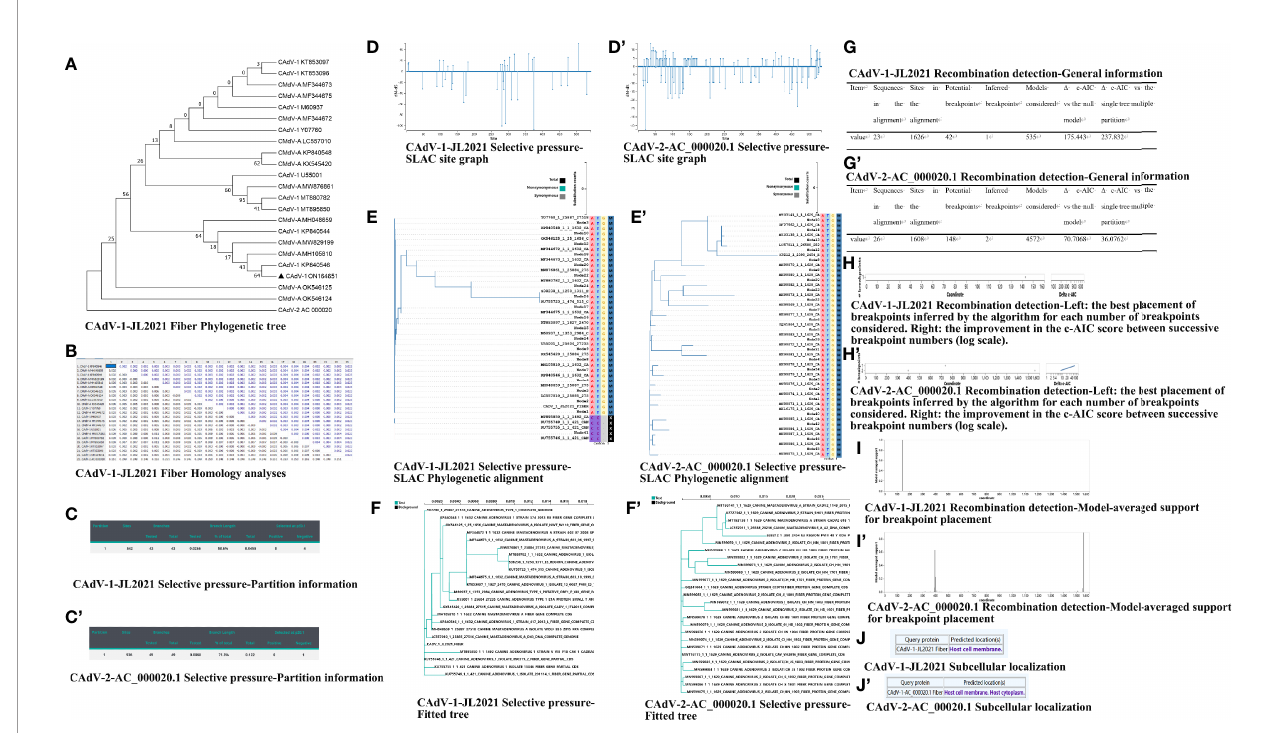
FIGURE 2 | The nucleotide analysis of the Fiber. (A) CAdV-1-JL2021 Fiber Phylogenetic tree; (B) CAdV-1-JL2021 Fiber Homology analyses; (C) CAdV-1-JL2021 Selective pressure-Partition information; (C ’ ) CAdV-2-AC_000020.1 Selective pressure-Partition information; (D) CAdV-1-JL2021 Selective pressure-SLAC site graph; (D ’ ) CAdV-2-AC_000020.1 Selective pressure-SLAC site graph; (E) CAdV-1-JL2021 Selective pressure-SLAC Phylogenetic alignment; (E ’ ) CAdV-2- AC_000020.1 Selective pressure-SLAC Phylogenetic alignment; (F) CAdV-1-JL2021 Selective pressure-Fitted tree; (F ’ ) CAdV-2-AC_000020.1 Selective pressure- Fitted tree; (G) CAdV-1-JL2021 Recombination detection-General information; (G ’ ) CAdV-2-AC_000020.1 Recombination detection-General information; (H) CAdV- 1-JL2021 ecombination detection-Left: the best placement of breakpoints inferred by the algorithm for each number of breakpoints considered. Right: the improvement in the c-AIC score between successive breakpoint numbers (log scale). (H ’ ) CAdV-2-AC_000020.1 Recombination detection-Left: the best placement of breakpoints inferred by the algorithm for each number of breakpoints considered. Right: the improvement in the c-AIC score between successive breakpoint numbers (log scale). (I) CAdV-1-JL2021 Recombination detection-Model-averaged support for breakpoint placement; (I ’ ) CAdV-2-AC_000020.1 Recombination detection-Model-averaged support for breakpoint placement. (J) CAdV-1-JL2021 Subcellular localization; (J ’ ) CAdV-2-AC_00020.1 Subcellular